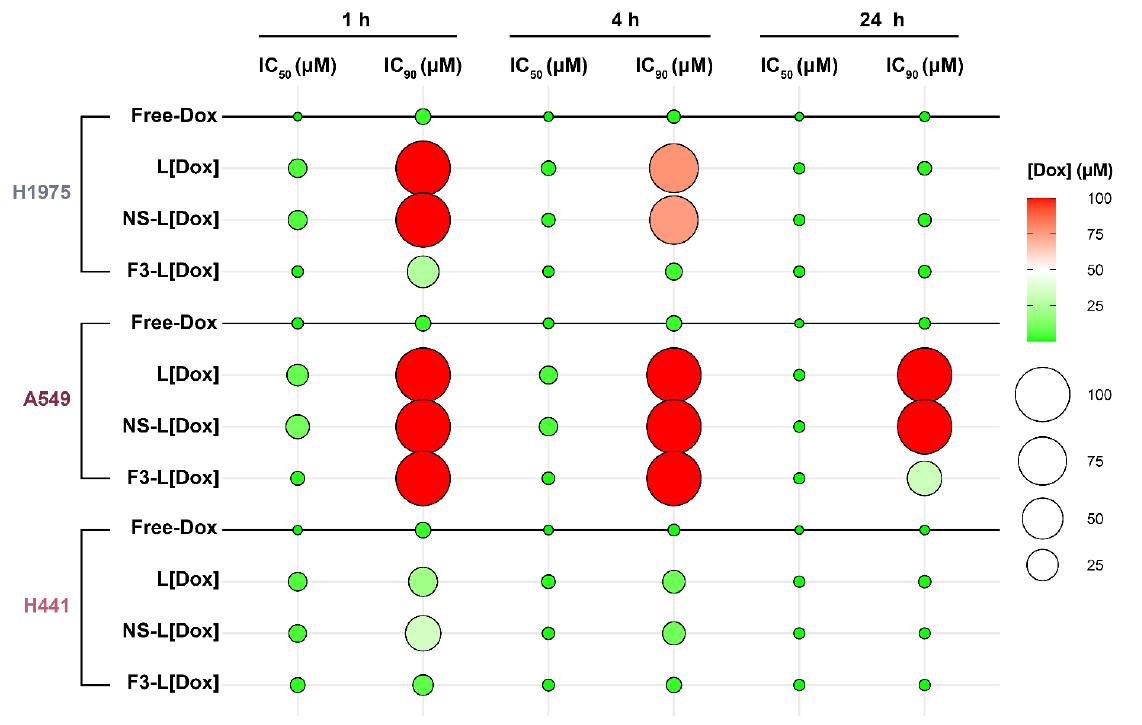
Figure 6. Cytotoxic potential of different formulations of liposomal doxorubicin against lung cancer cells. H1975, A549, and H441 lung cancer cells were incubated with increasing concentrations of doxorubicin (Dox), free or encapsulated in non-targeted (L[Dox]) or targeted pH-sensitive pegylated liposomes, functionalized either with a non-specific peptide (NS-L[Dox]) or nucleolin-binding F3 peptide (F3-L[Dox]), for the indicated periods. The medium was then replaced with fresh medium and the experiment was prolonged for a total of 96, 120, or 144 h, for A549, H1975, and H441 cells, respectively. Data represent the mean inhibitory concentration for 50% or 90% effect (IC 50 and IC 90 , respectively). Circle size and color reflect the mean Dox concentration value (µM, n = 3): the smaller the size and the greener the color, the higher the cytotoxic potency. See Supplementary Table S5 for detailed data.